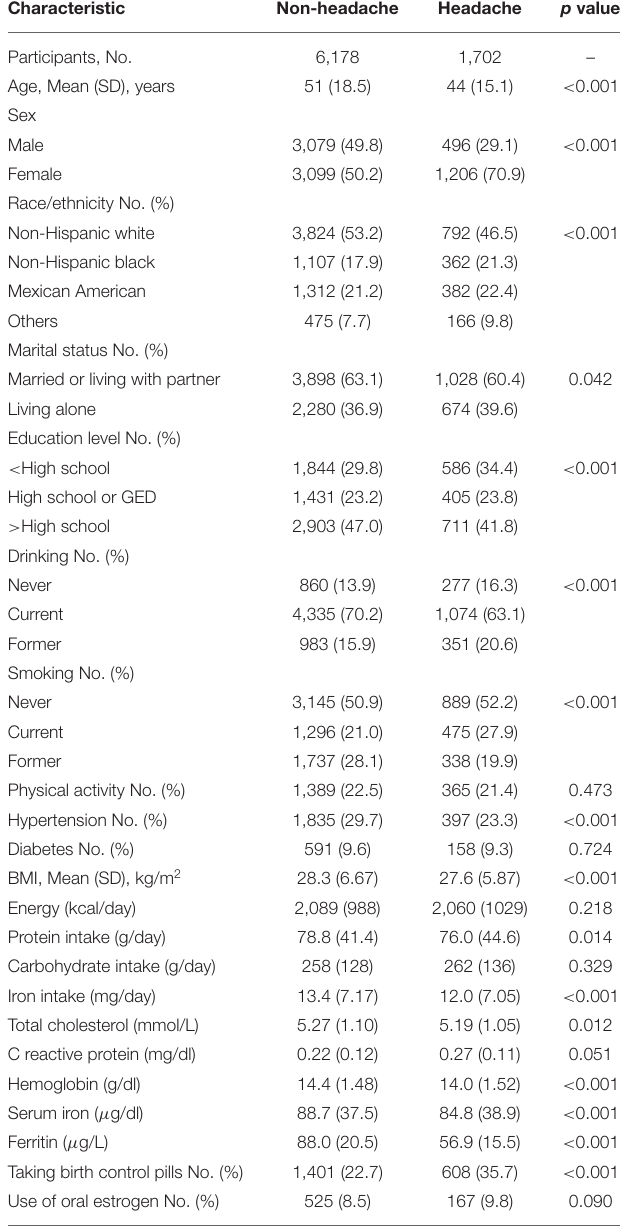
TABLE 1 | Characteristics of participants with or without